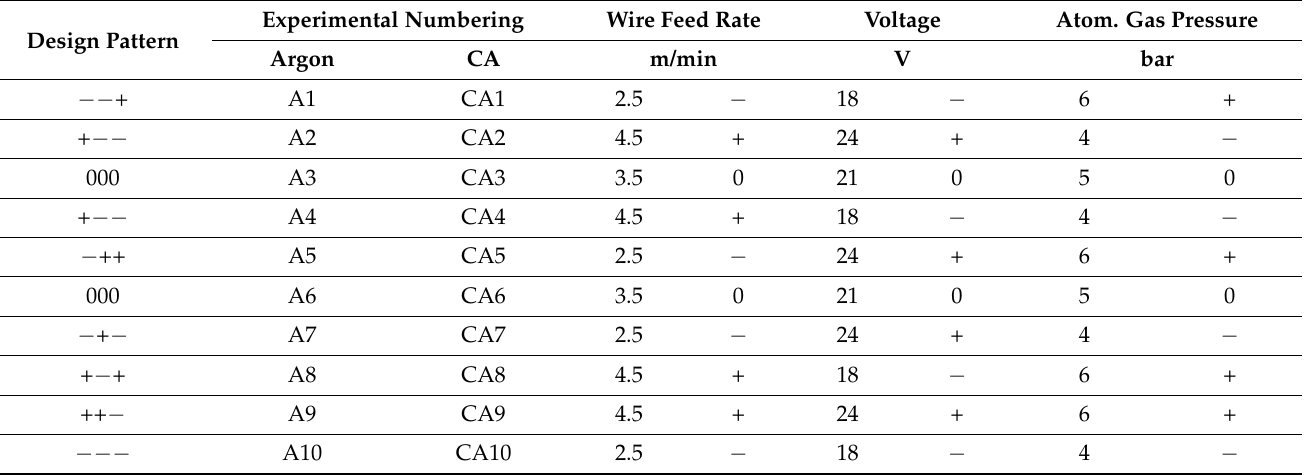
Table 3. Full-factorial plan for the TWAS process; parameters: wire feed rate (2.5, 3.5, 4.5